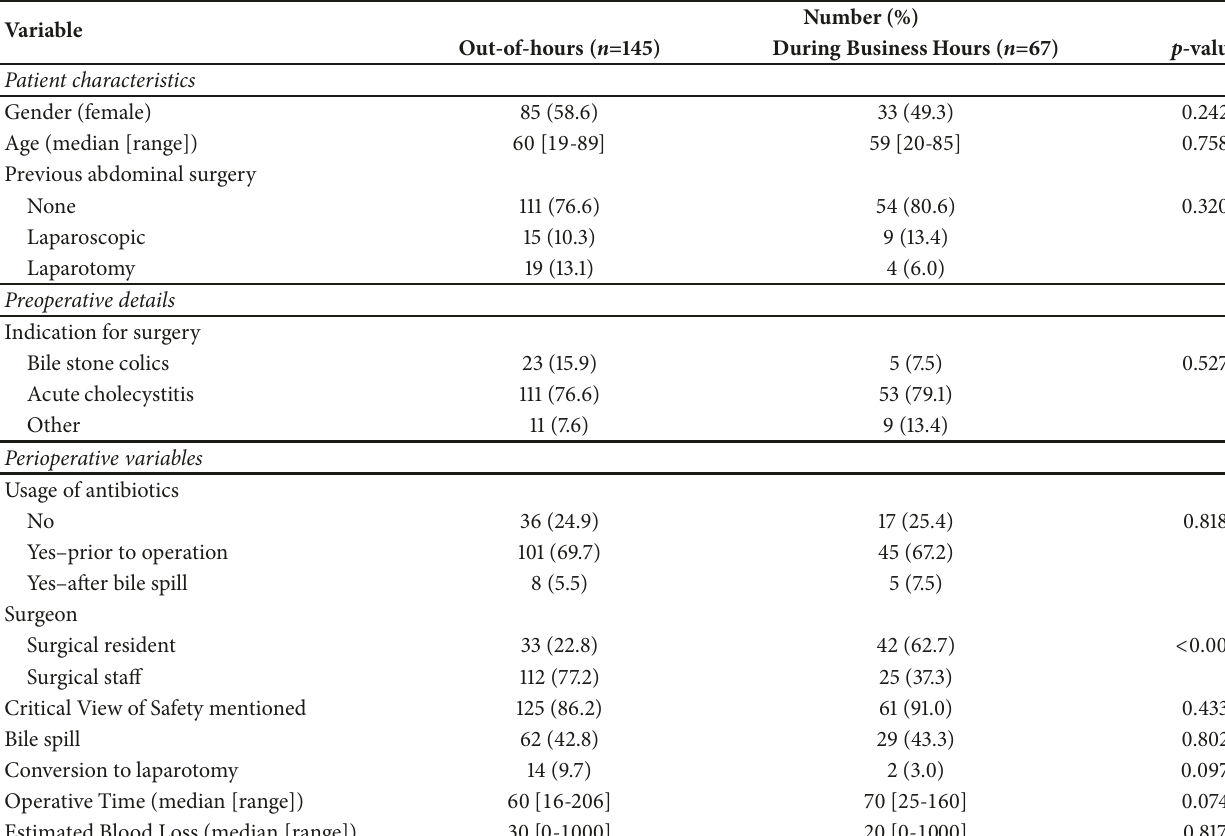
Table 3: Patient clinicopathologic and operative characteristics; comparing emergency in daytime to those at night during business hours. Variable